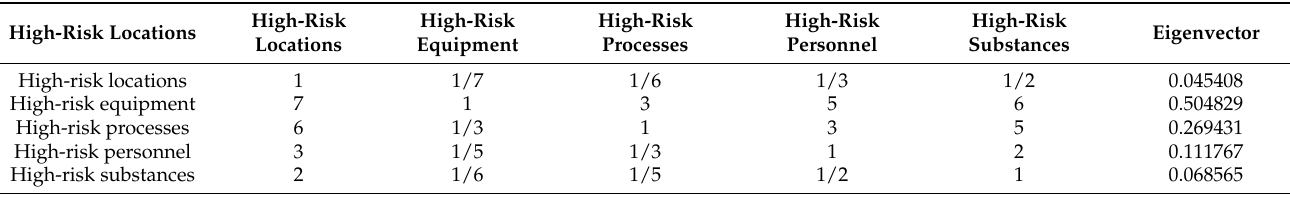
Table 3. Priority comparison of cluster of high-risk locations.